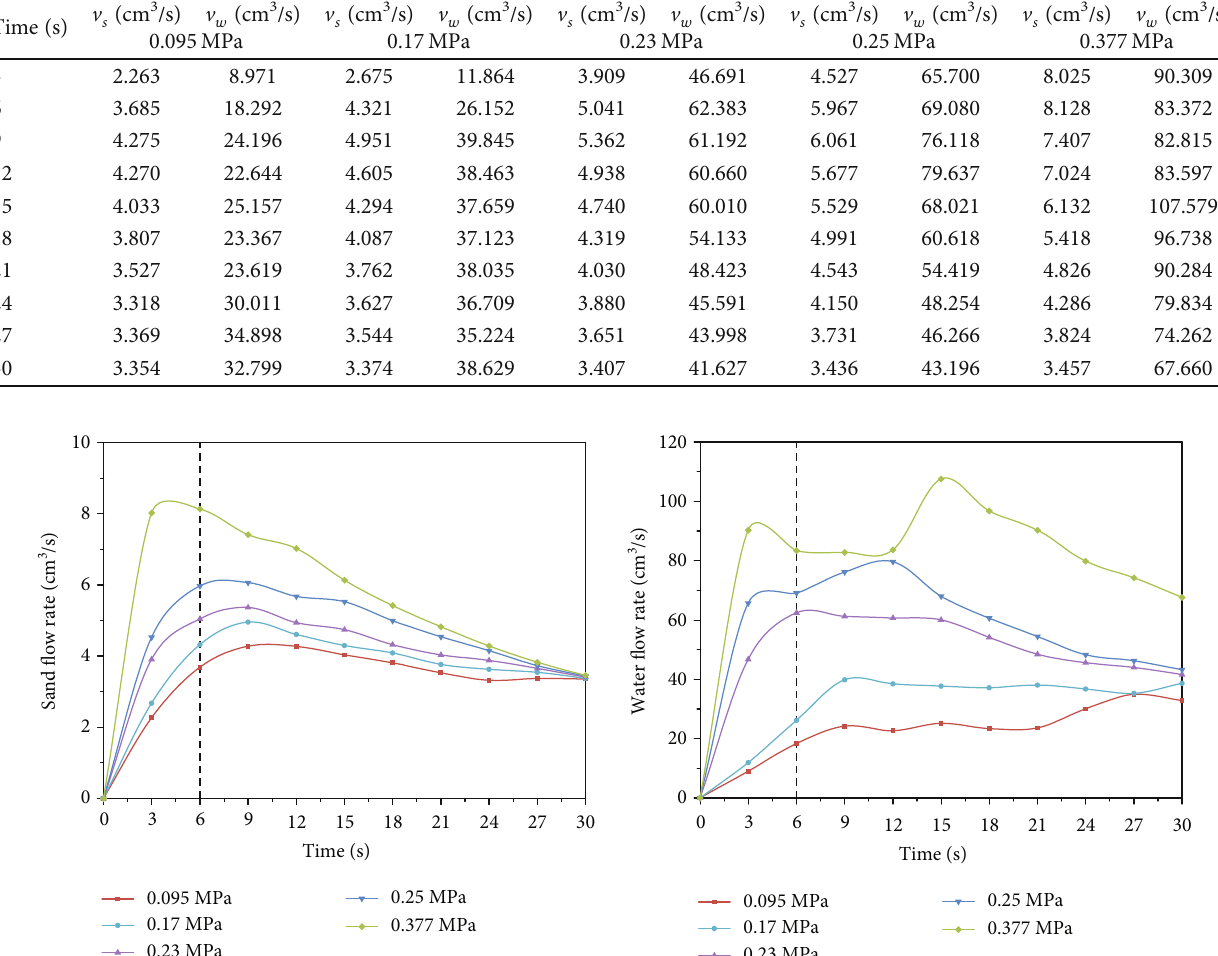
Table 3: The evolution of fl ow rates for (a) Aeolian sand particles and (b) water.